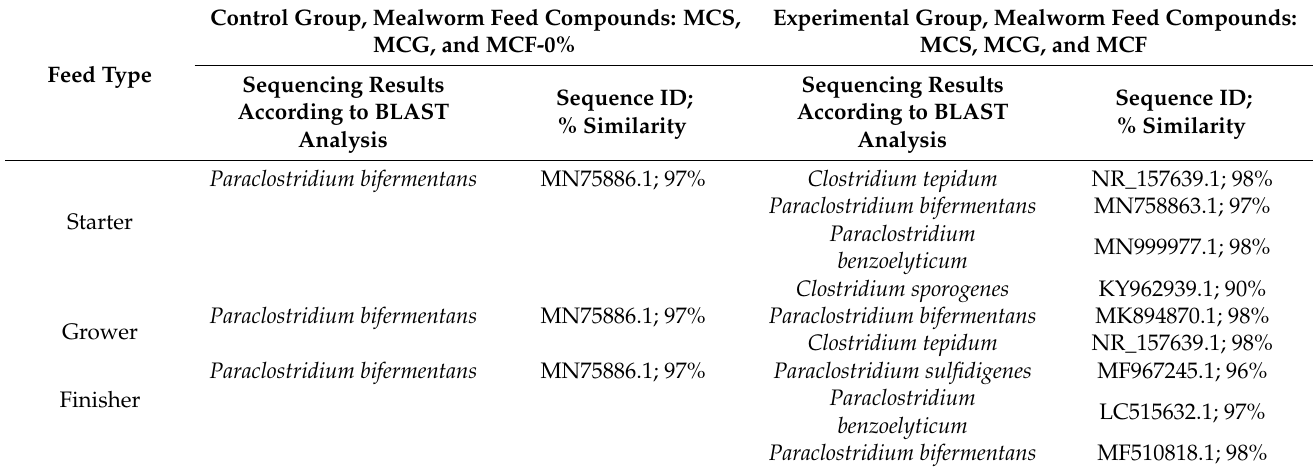
Table 9. Sequencing results for the mealworm feed compound